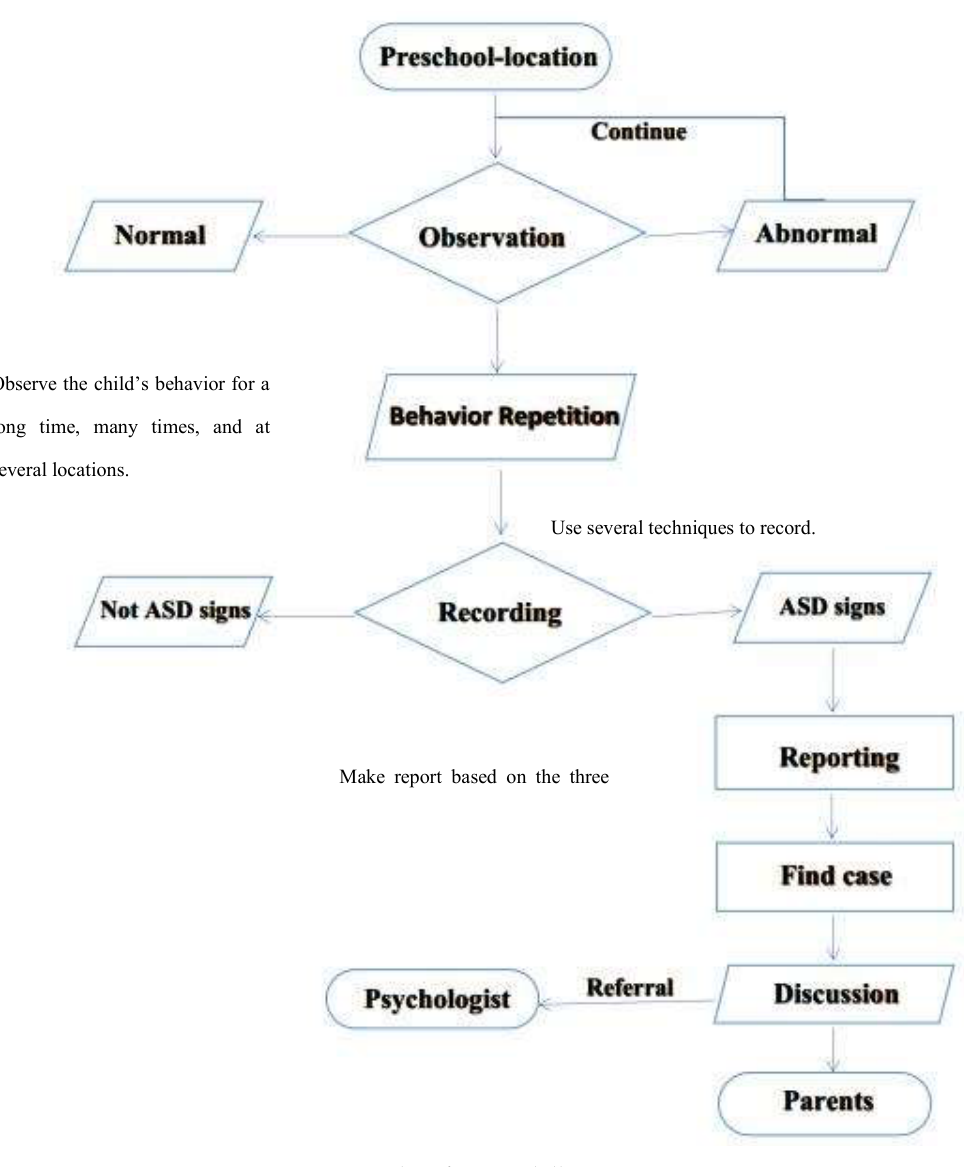
Figure 3. Identification skills process.